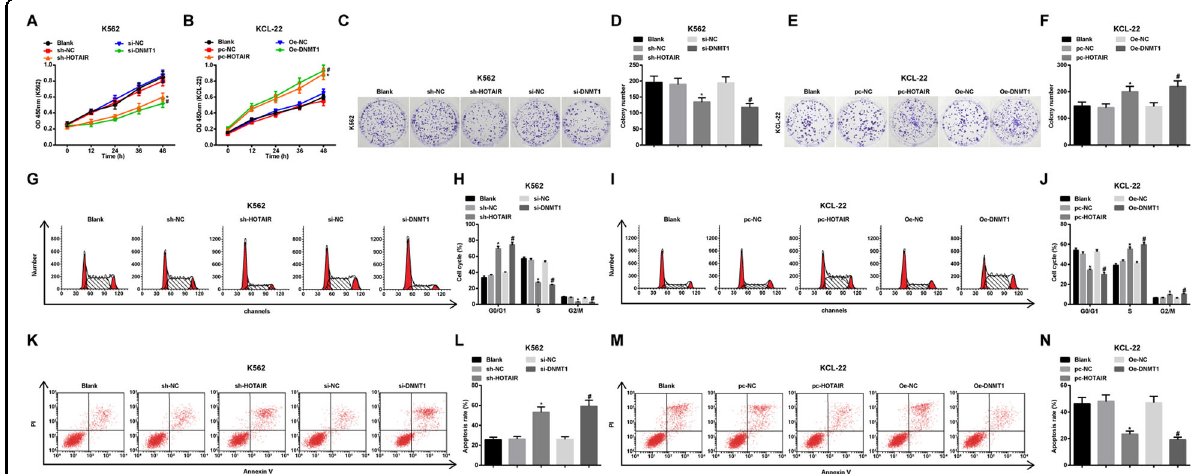
Fig. 3 Downregulated HOTAIR or DNMT1 reduces the proliferation, colony formation and cell cycle progression, as well as increases apoptosis rate of CML cells. A K562 cell proliferation activity in each group. B KCL-22 cell proliferation activity in each group. C Colony formation of K562 cells in each group. D Number of colonies of K562 cells in each group. E Colony formation of KCL-22 cells in each group. F Number of colonies of KCL-22 cells in each group. G Cell cycle of K562 cells in each group. H K562 cell cycle ratio in each group. I Cell cycle of KCL-22 cells in each group. J KCL-22 cell cycle ratio in each group. K Apoptosis of K562 cells in each group. L Apoptosis rate of K562 cells in each group. M Apoptosis of KCL-22 cells in each group. N Apoptosis rate of KCL-22 cells in each group. In K562 cells, * P < 0.05 vs. the sh-NC group, # P < 0.05 vs. the si-NC group. In KCL-22 cells, * P < 0.05 vs. the pc-NC group, # P < 0.05 vs. the OE-NC group. N = 3. Measurement data were depicted as mean ± standard deviation. Comparisons among multiple groups were assessed by one-way ANOVA followed by Tukey ’ s multiple comparisons test.